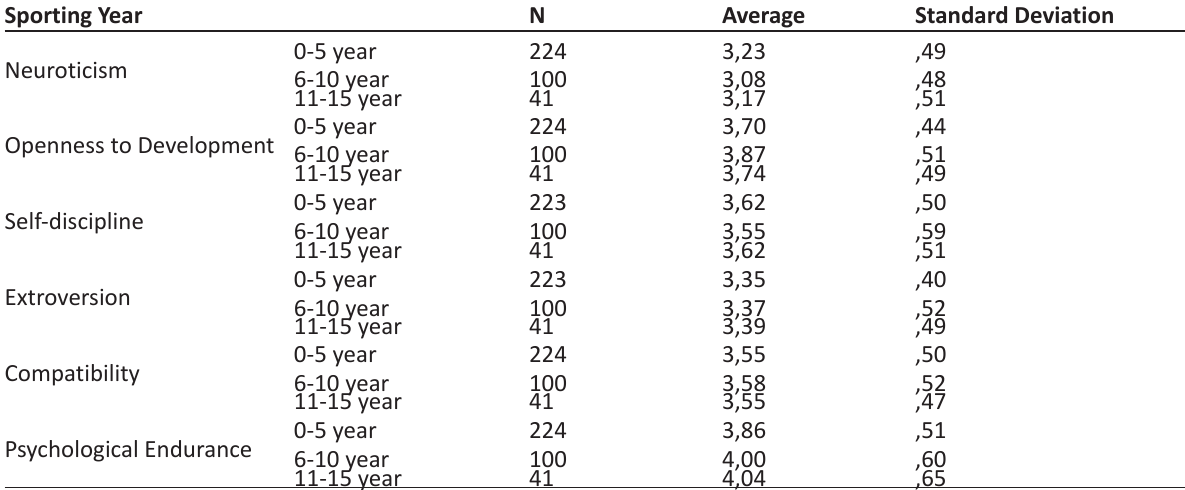
Table 3. F-test results regarding the difference between psychological endurance and personality characteristics according to the year of sport variance.